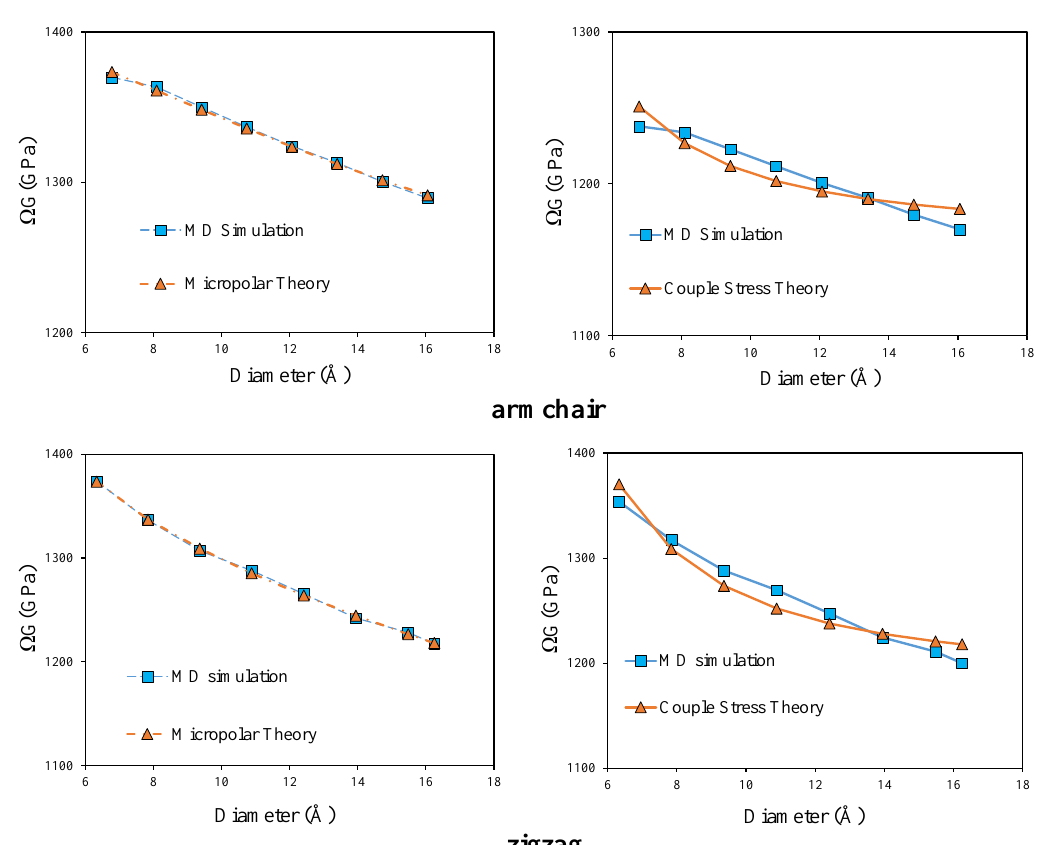
Figure 4. Comparison of apparent shear modulus from micropolar and couple stress models with MD results- the abscissa refers to the mean diameter, d 0